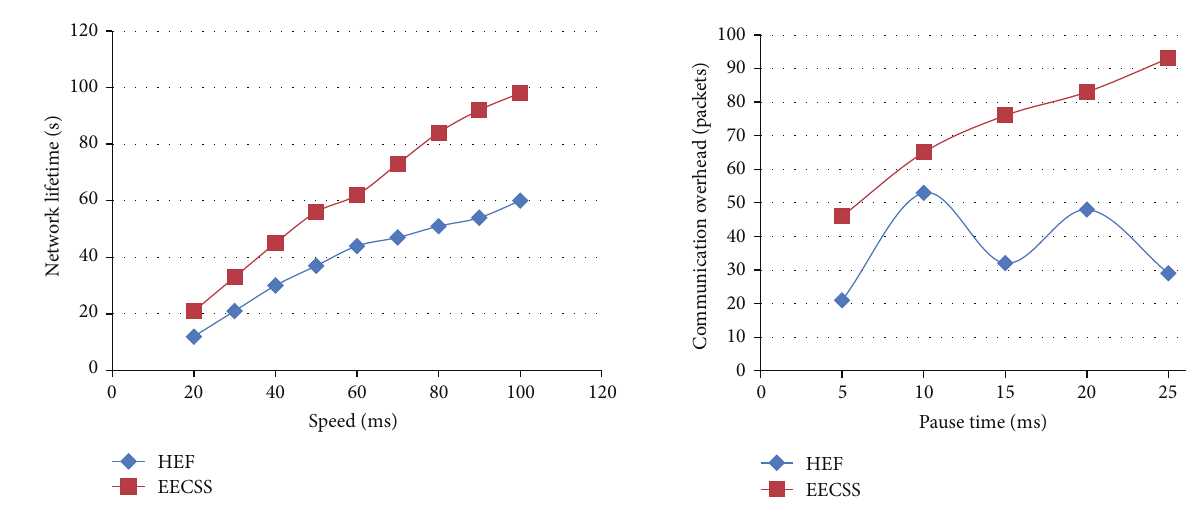
Figure 5: Throughput versus end to end delay.